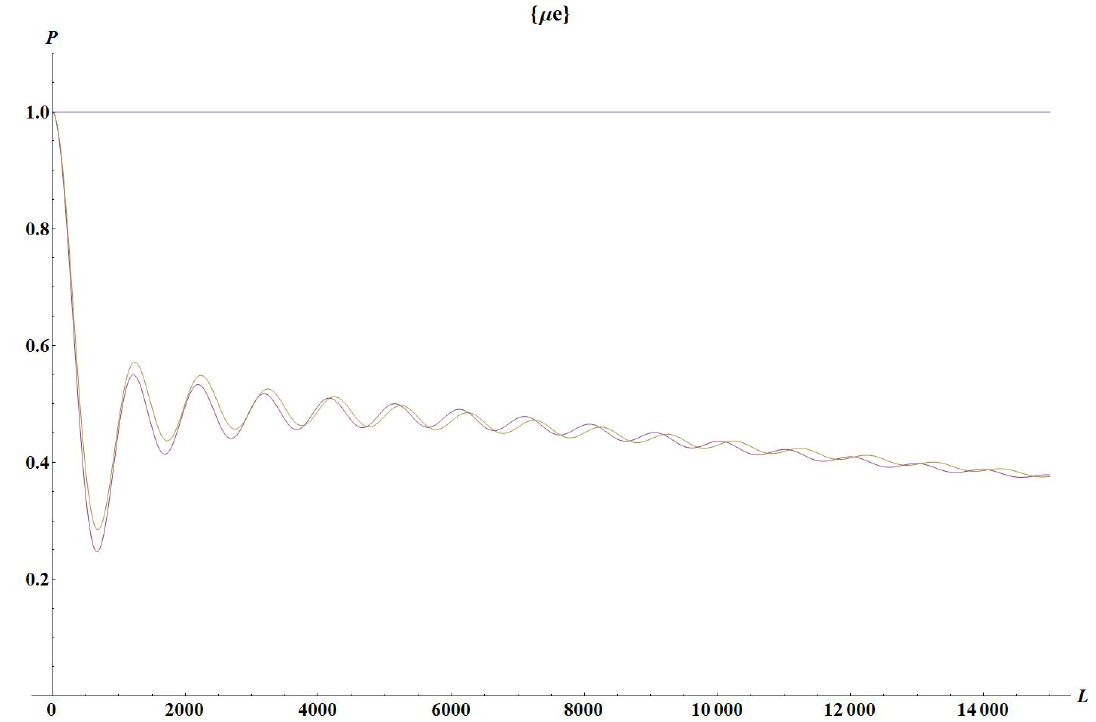
Figure 11. Comparison between oscillation probability integral averaged on energy range values from 1 GeV to 10 GeV , in LI scenario (blue line) and LIV scenario (red line), with δ f 32 = 10 − 23 and δ f 21 = 10 − 25 . Baseline L in km.